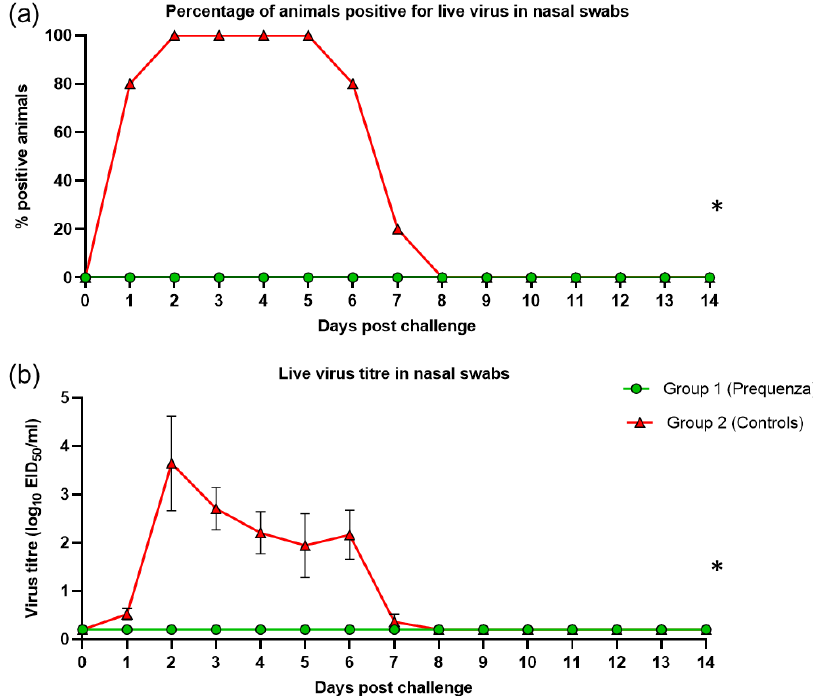
Figure 4. ( a ) Percentage of horses positive for live virus in nasal swabs and ( b ) Live virus titre in nasal swabs in groups 1 and 2 after challenge with H3N8 A/equine/Venlo/19 (FC1 sub-lineage). Green square = group 1, Equilis Prequenza vaccinated group; red triangle = group 2, unvaccinated control group. Error bars represent SEM. Inferential statistics: significant difference ( p < 0.05) between groups 1 and 2 (*) (overall period one to seven dpc).